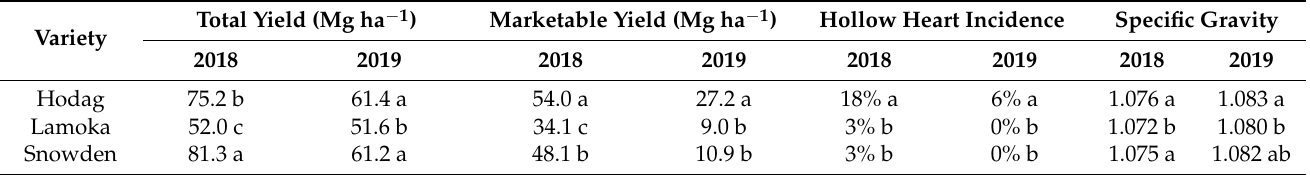
Table 3. Total yield, marketable yield, hollow heart incidence and specific gravity of the three chipping varieties for 2018 and 2019. Numbers followed by the same letter are not significantly different at α = 0.05.